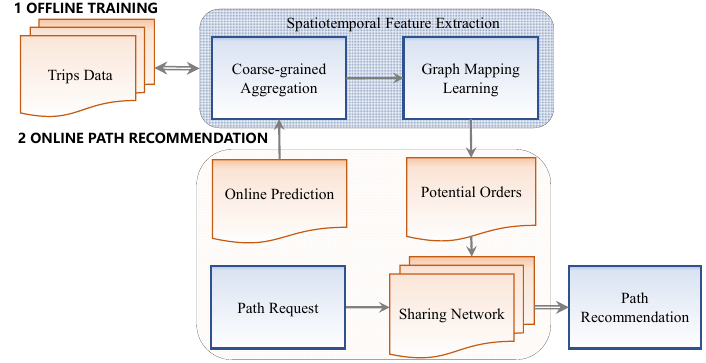
Figure 5. Data-driven path recommendation process.